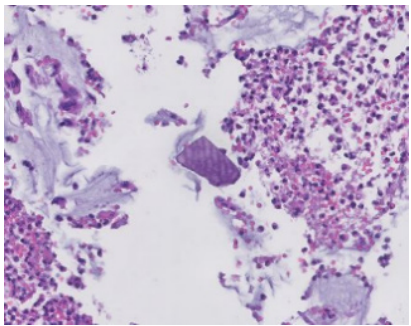
Figure 4: Medium power image of fibrinopurulent exu- date and Kayexalate crystal (Hematoxylin and eosin, 10× magnification).